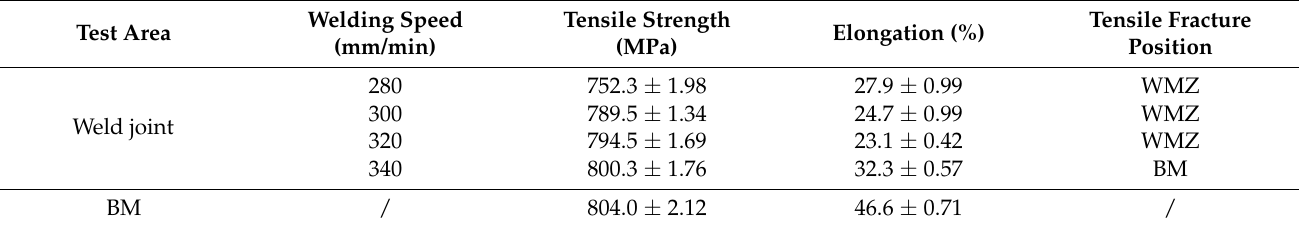
Table 3. Tensile test results of the 2205 DSS BM and welded